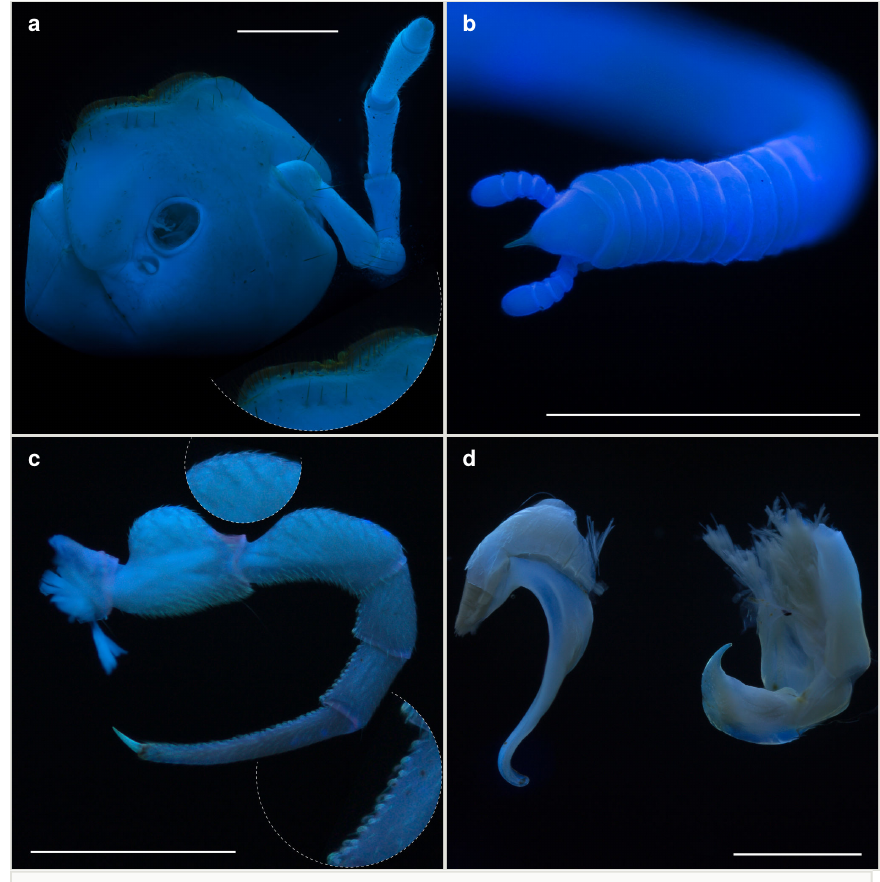
Figure 2. Fluorescent images of millipedes imaged in 350 nm UV light with a Canon 199A modi fi ed fl ash. Scale bars = 1 mm.